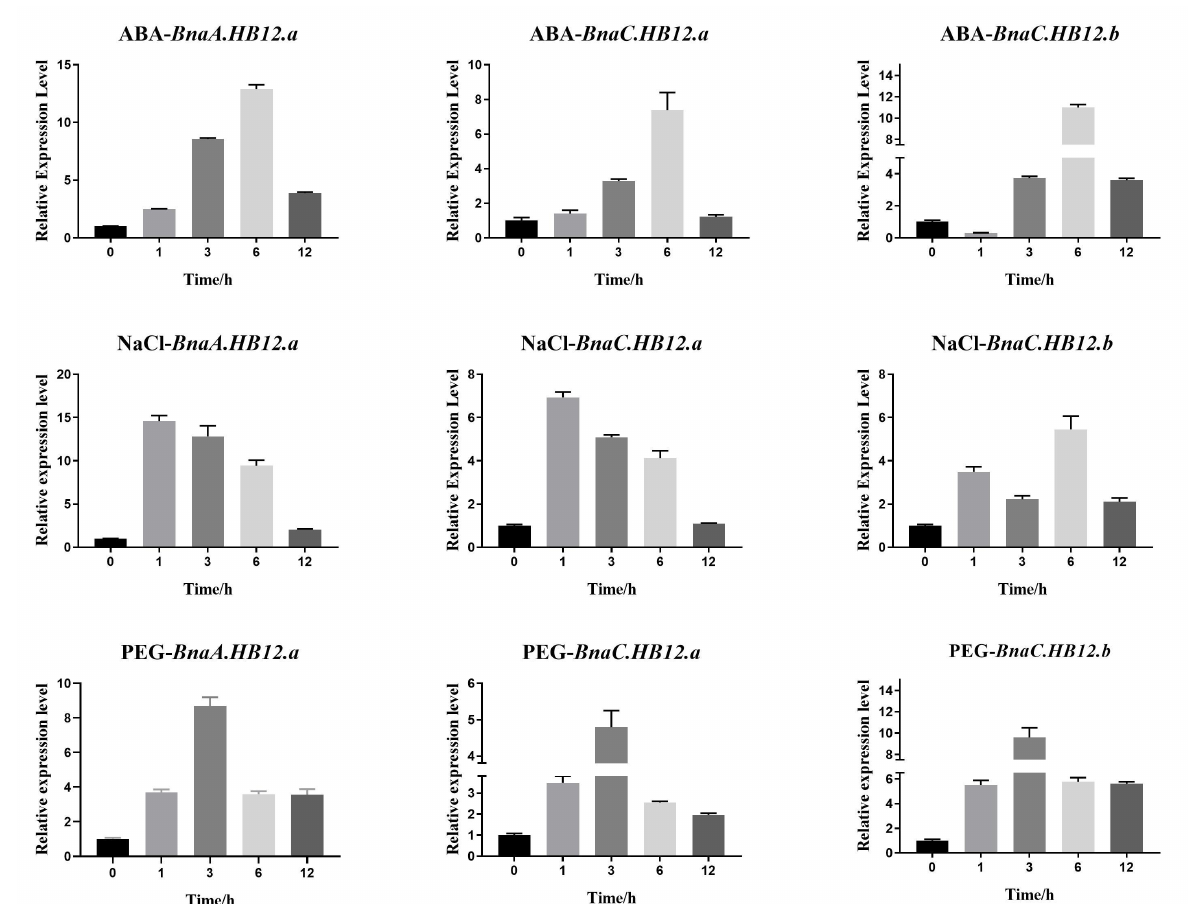
Figure 6. The expression level of BnaA.HB12.a , BnaC.HB12.a , and BnaC.HB12.b after treatment with ABA, NaCl, and PEG. BnActin was used as the internal reference. The genes were all upregulated after these